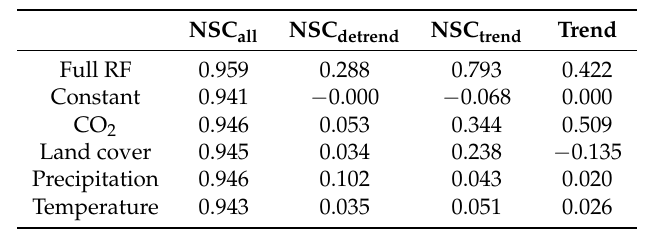
Table 2. Nash–Sutcliffe coefficients (NSC) and mean trend for random forest (RF) predictions of the normalized difference vegetation index (NDVI). The full RF model includes all time-varying factors. The other predictions are with either interannually constant factors or only one time-varying factor. The mean trend is in 10 − 3 units per year. For comparison, the mean trend calculated from observations is 0.448 × 10 − 3 per